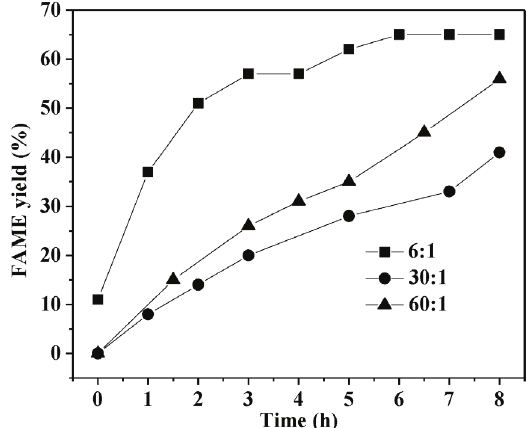
Fig. 2 – FAME yield from Karanja oil at different reaction times for methanol to oil ratio of 6:1, 30:1, and 60:1. Reaction conditions: catalyst amount = 18 wt% of oil; temperature = 393 K; rpm = 750; reaction mixture volume= 341